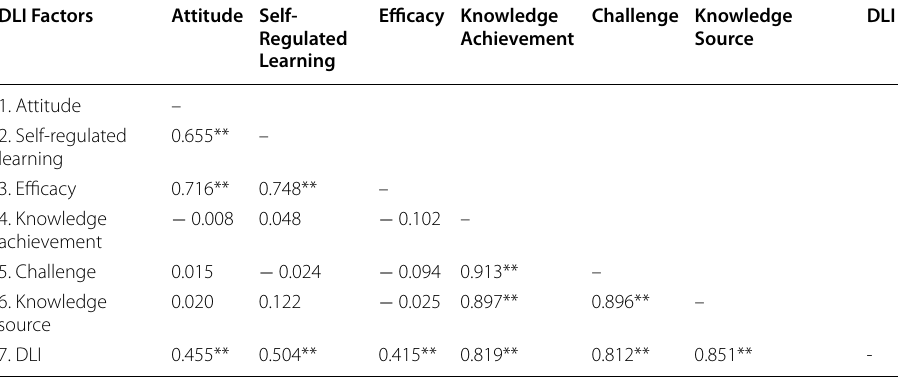
**Correlation is significant at the 0.01 level (2‑tailed)